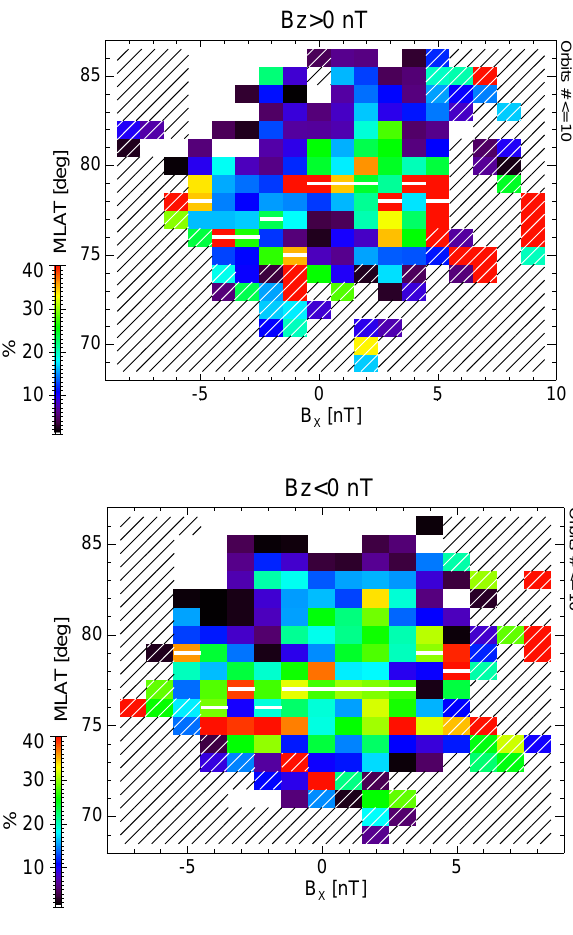
Fig. 6. The cusp latitudinal location as a function of the IMF B X component for B Z > 0nT (top) and B Z < 0nT